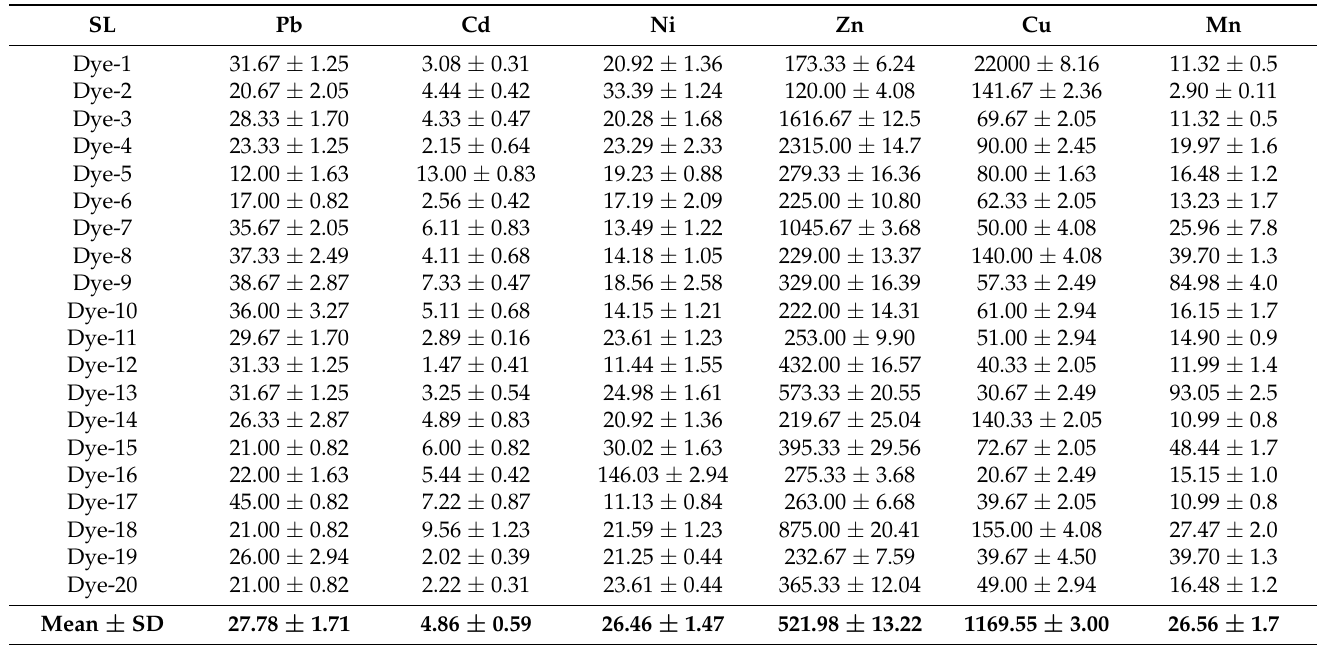
Table 2. Concentration (mg kg − 1 ) of heavy metal in different dye complexes used in handloom dyeing factories in the Chalan beel area (n = 3); Mean ± SD.